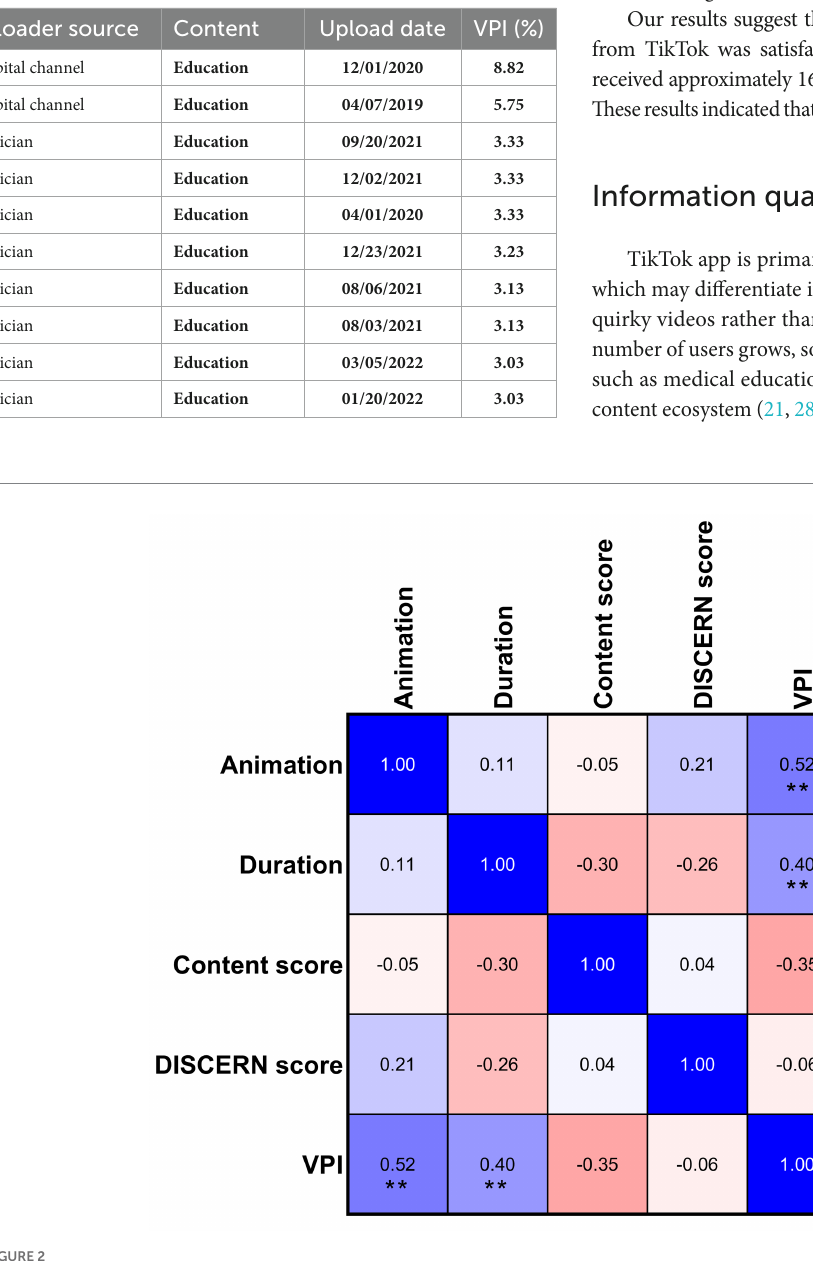
TABLE 3 General characteristics and VPI values of the top 10